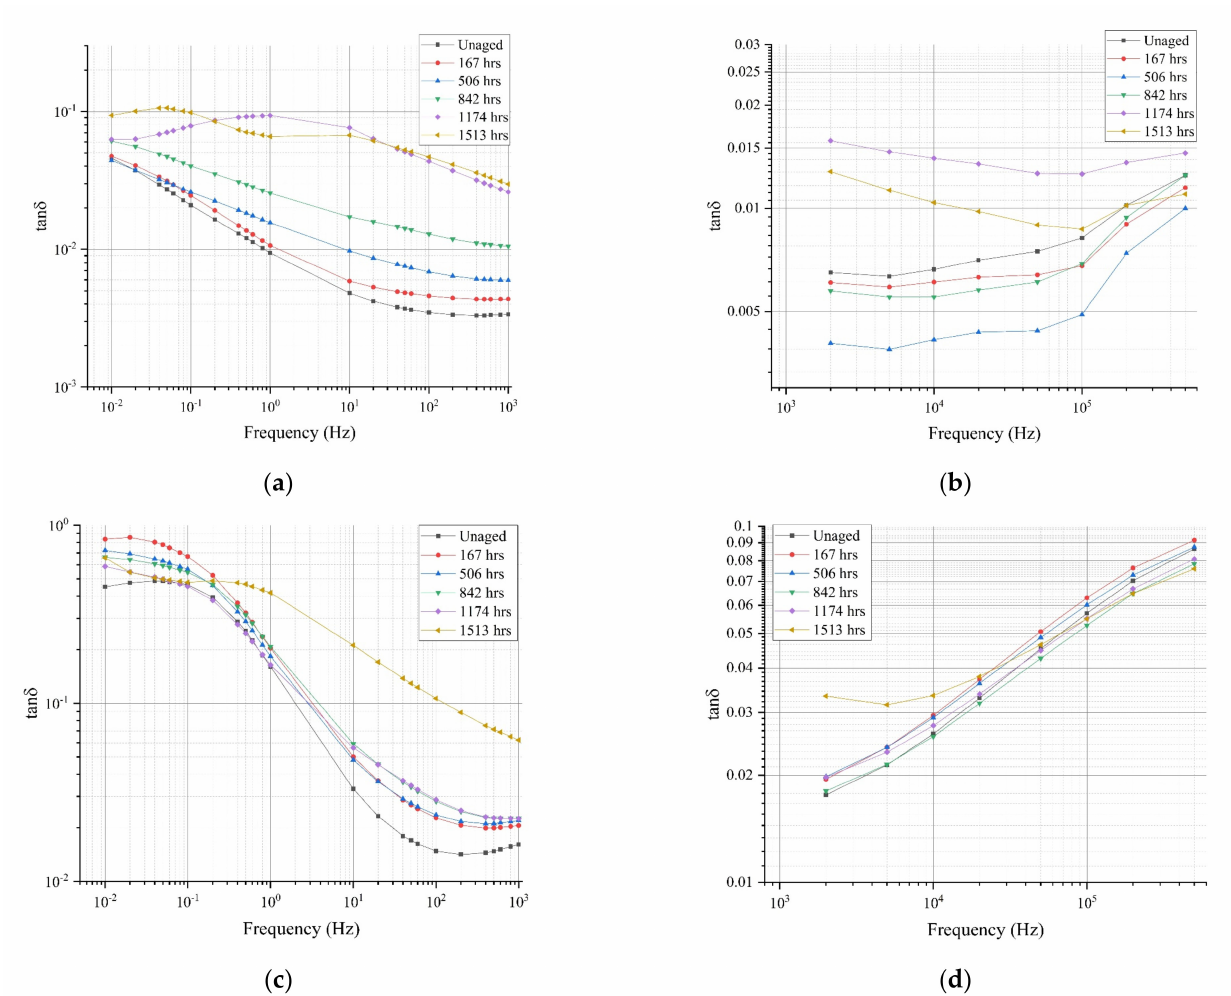
Figure 5. tan δ vs. frequency, EPR insulation: ( a ) 10 mHz to 1 kHz, ( b ) 2 kHz to 500 kHz, CSPE jacket, ( c ) 10 mHz to 1 kHz, and ( d ) 2 kHz to 500 kHz for different thermal aging